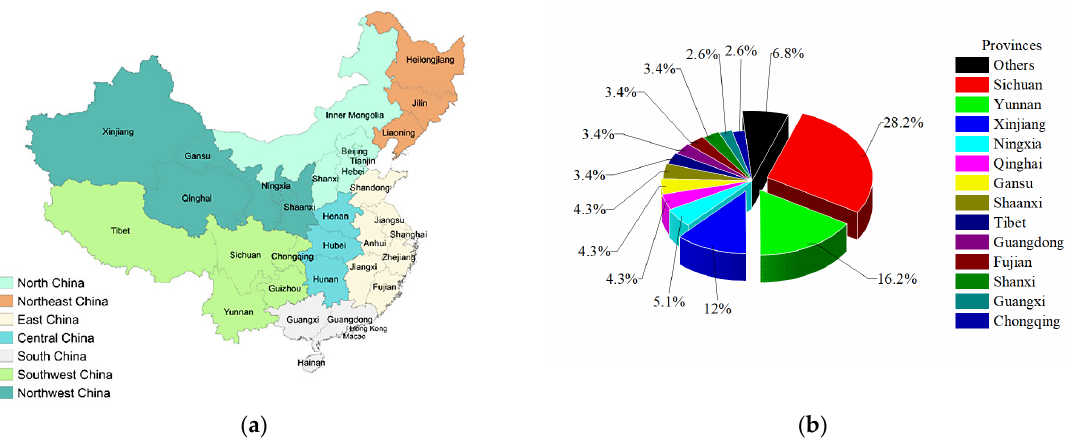
Figure 3. ( a ) Geographic Divisions of China (Mainland China and Hainan Province only); ( b ) National percentage of major mine debris flow in China by province.